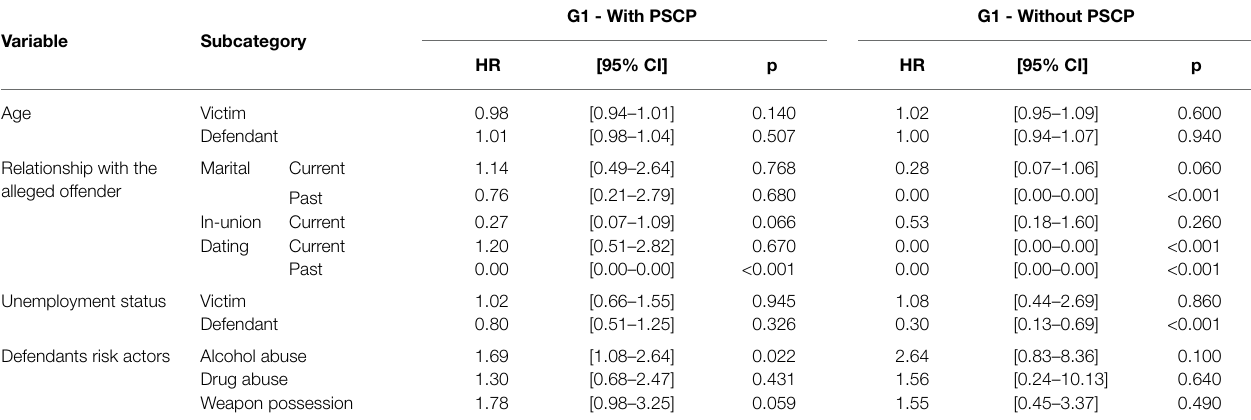
TABLE 5 | CoxPH regression model for Survival effect on re-entries in